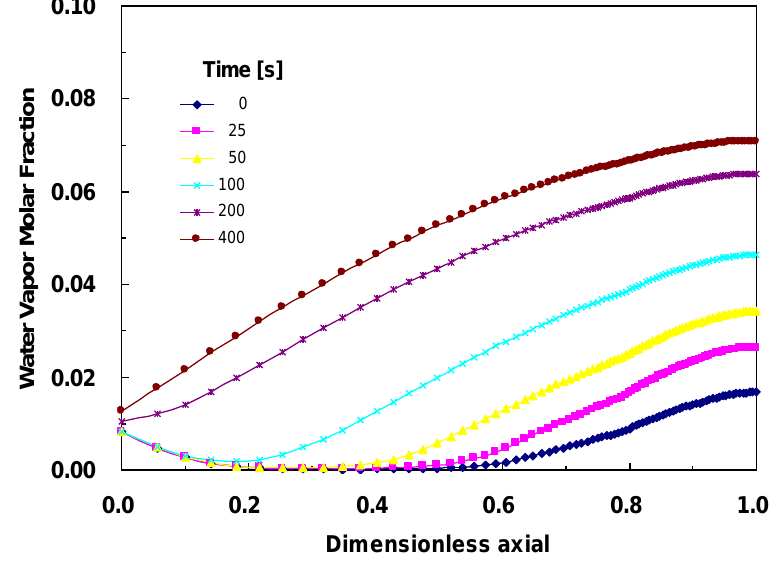
Figure 10. Distribution profile of water vapor molar fraction during a step change of potential from 0.9 V to 0.4